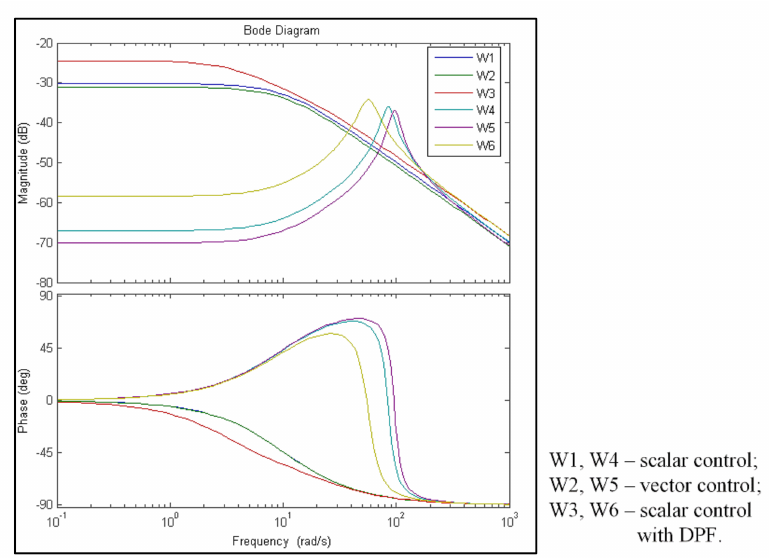
Figure 14. Frequency response and phase response asynchronous drive with different control algorithms (W1, W2, W3—with low load, W4, W5, W6—when load surges).